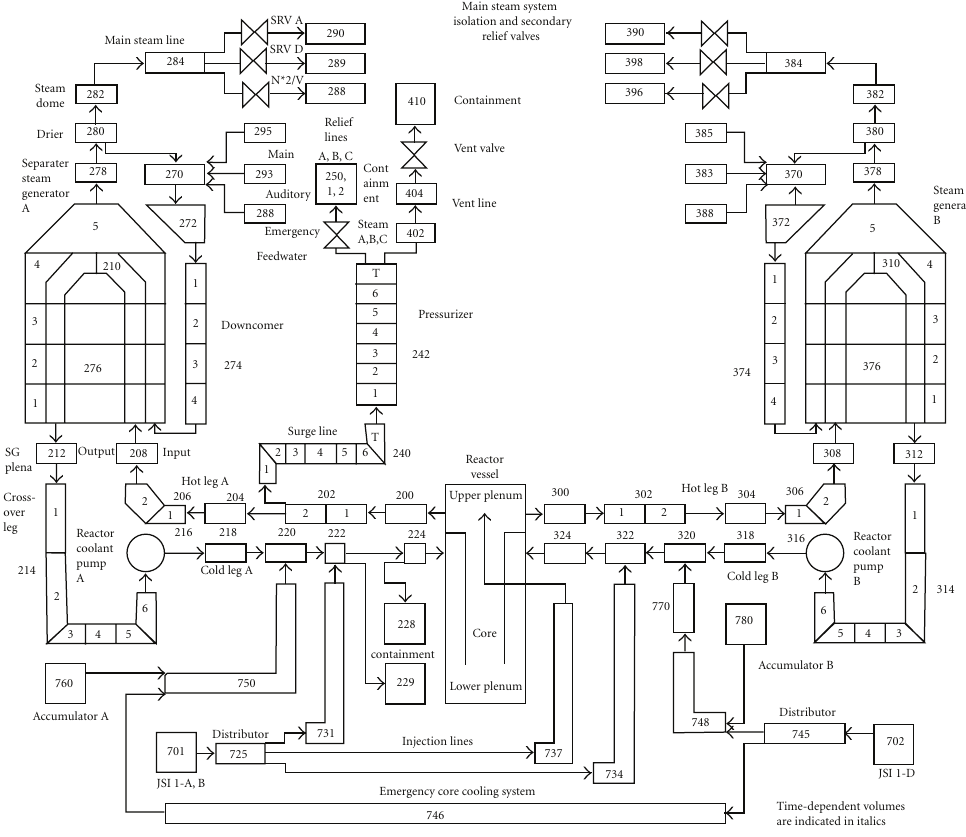
Figure 9: Beznau nodalization used for RELAP/SDAPSIM and SCDAP/RELAP5.